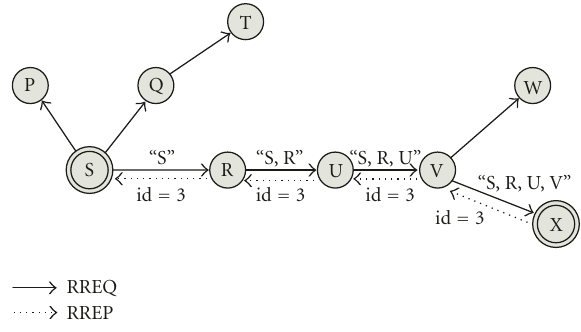
Figure 7: On-demand routing protocol route discovery (S: initia- tor; X: